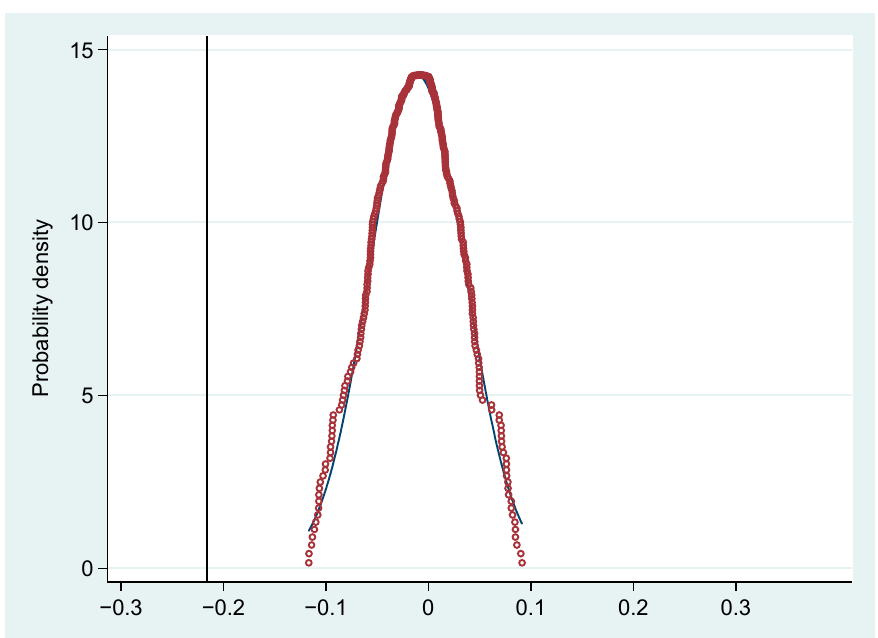
Figure 4. Parallel trend test.